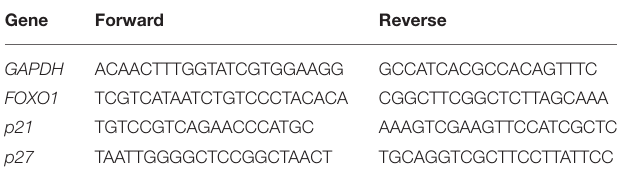
TABLE 1 | RT-PCR primer